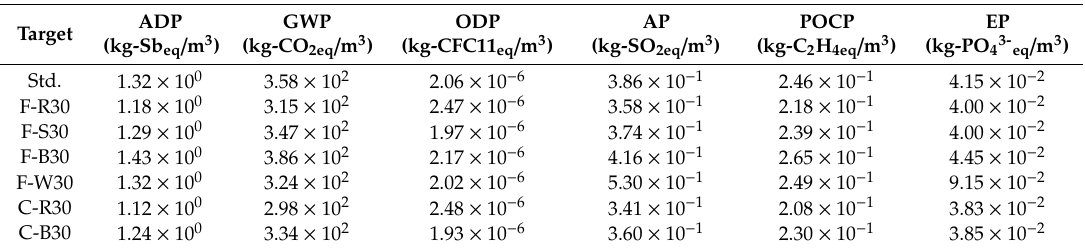
Table 7. Results of the Evaluation of the Six Environmental Impacts of the Evaluation